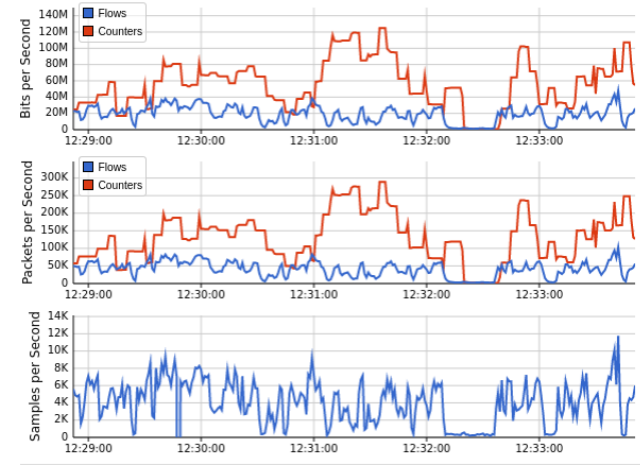
Figure 12. Performance dashboard for OF switches during DDoS attacks